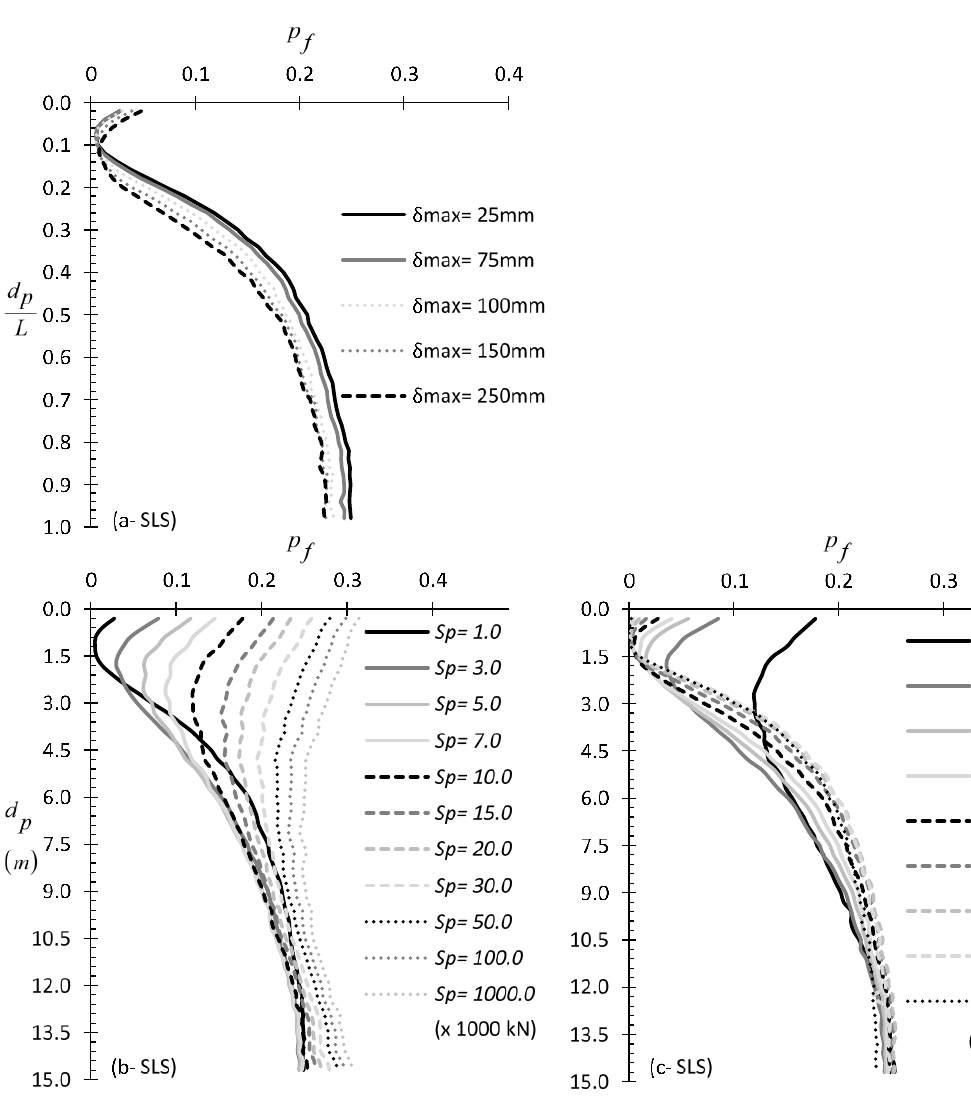
p  values, ( b ) f max p vs. d f p